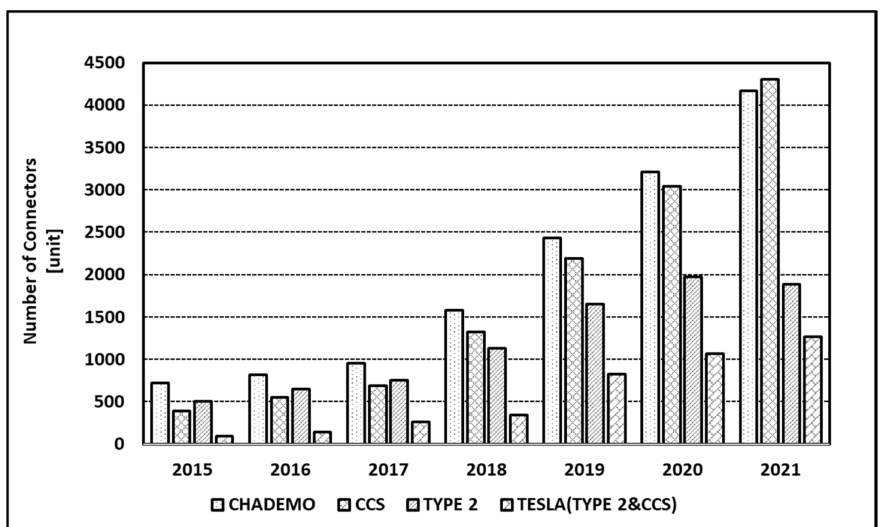
Figure 10. The number of public rapid charging connectors in the